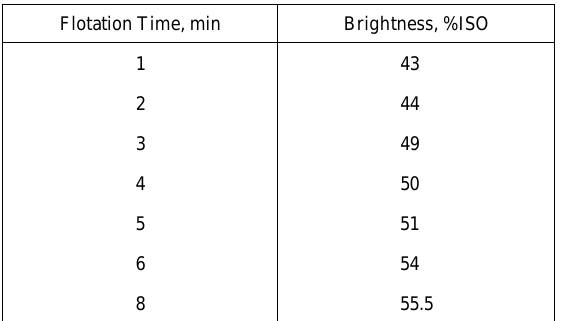
Table 1 Effect of flotation time on brightness of produced pulp (0.5% H 2 O 2 , 0.1% NH 4 OH, 2 minute